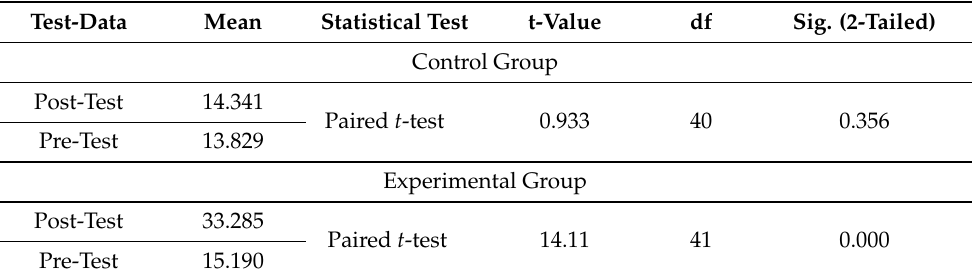
Table 3. Measuring student’s performance for learning OOP with and without the intervention of the prototype.